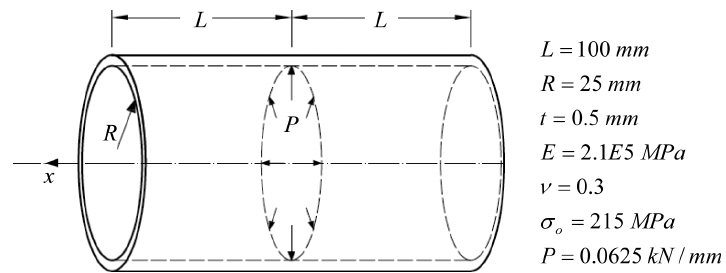
Fig. 12. Cylindrical shell subjected to a ring of pressure.